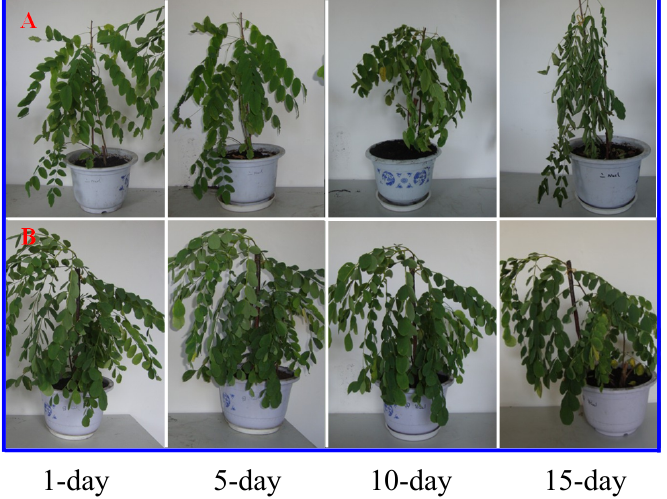
Figure 1. Morphological changes in Robinia pseudoacacia diploid (2×) and tetraploid (4×) plants growth after salt treatment (500 mM NaCl). Diploid ( A ) and tetraploid (4×) ( B ) plants were grown in a soil and sand mixture (2:1) after 1, 5, 10, and 15 days of salt treatment.